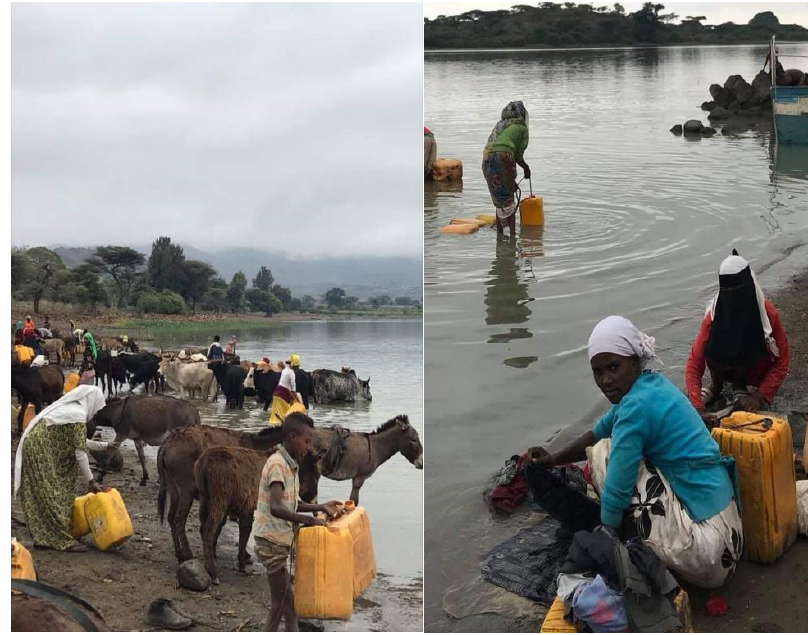
Figure 5. Lake Roobii/Qooqa Lake. Amudde. 27 January 2020. Photo, Author.